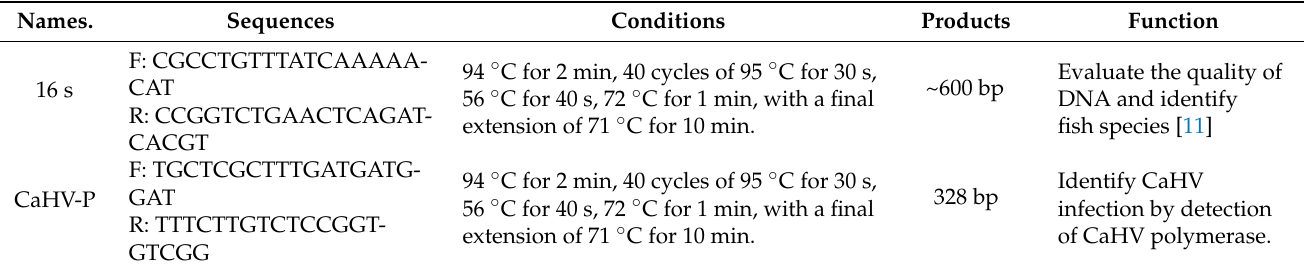
Table 1. Primers for